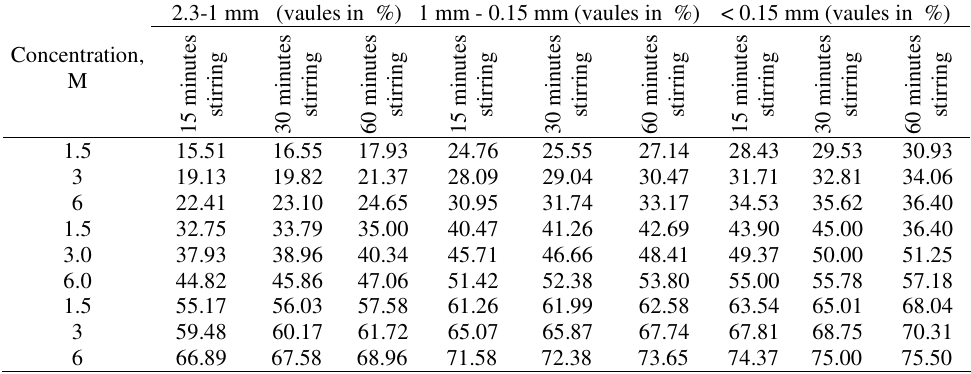
Table 4. Effect of sodium hydroxide on leaching of ash 2.3-1 mm (vaules in %) 1 mm - 0.15 mm (vaules in %) < 0.15 mm (vaules in